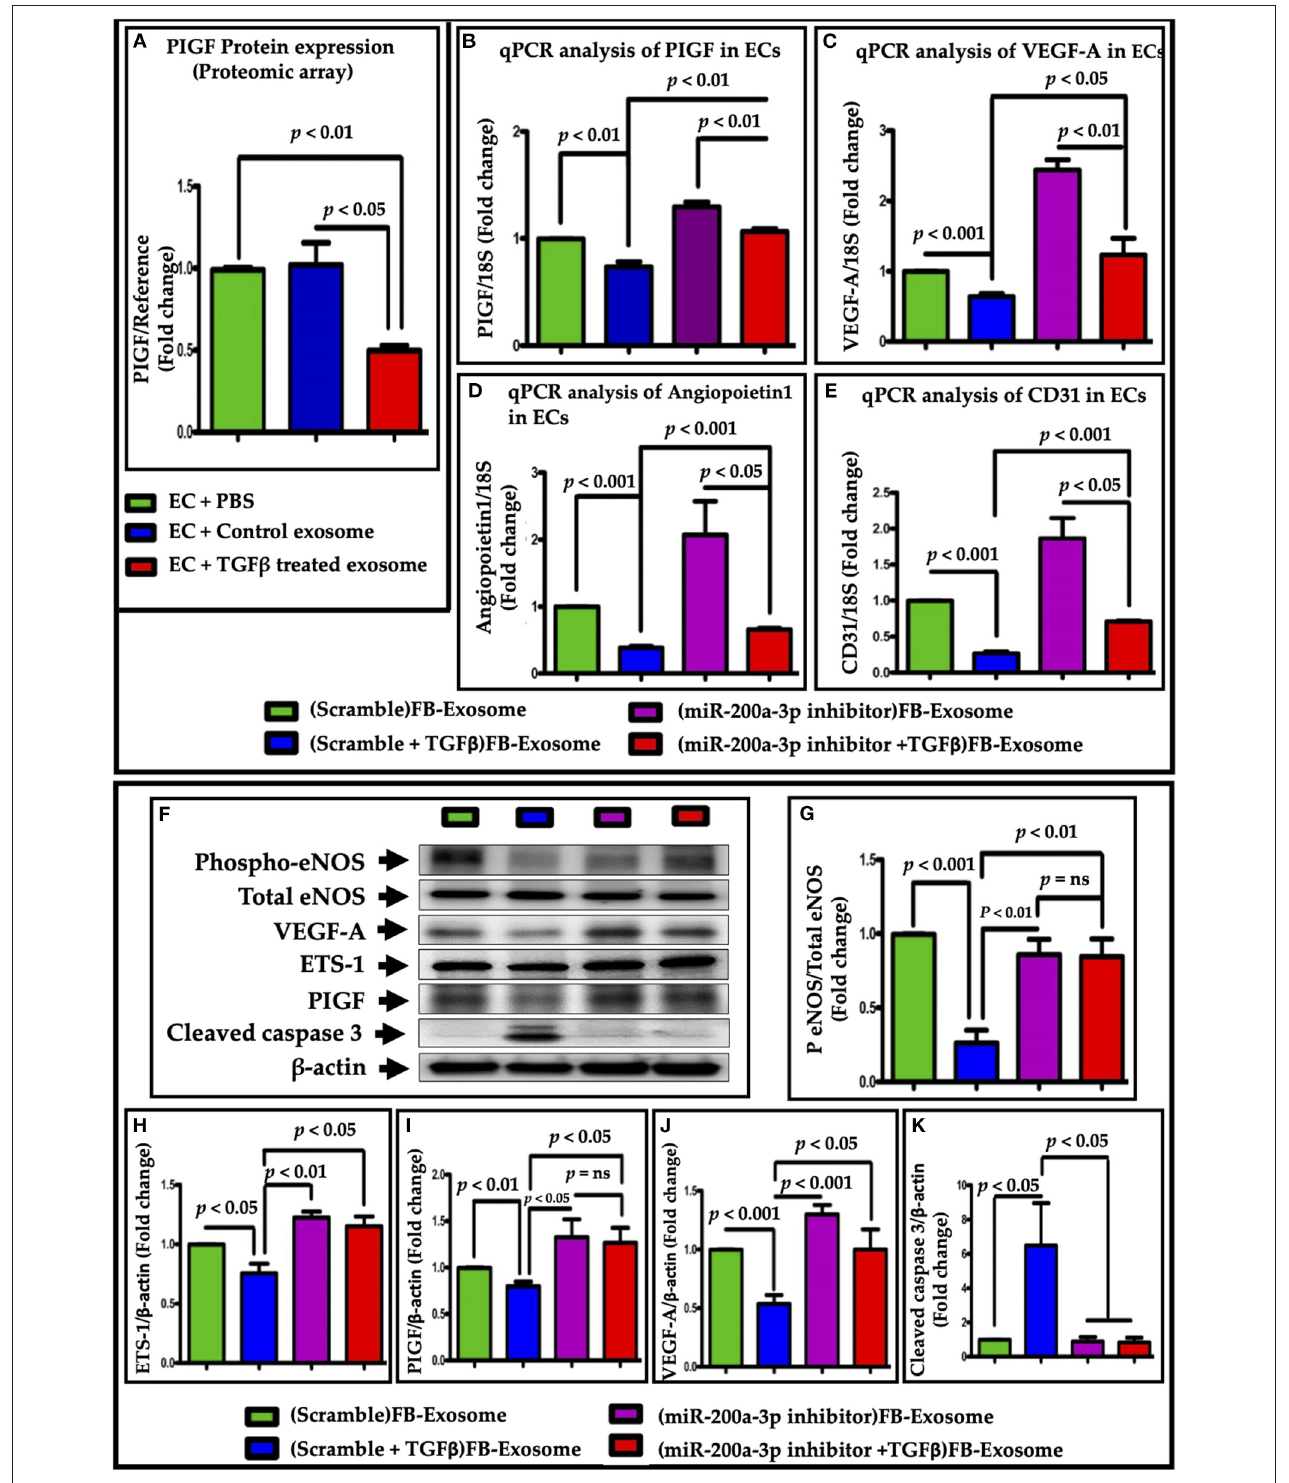
FIGURE 8 | miR-200a-3p packaged in fibroblast-derived exosomes altered expression of endothelial functional genes via PIGF growth factor inhibition. (A) ELISA-based angiogenesis proteomic profiling revealed a greatly reduced expression of PIGF. (B) PIGF expression was increased in ECs upon treatment with exosomes with inhibited miR-200a-3p. qPCR data showing an improved endothelial function, as assessed by (C) VEGF-A, (D) angiopoietin1 and (E) CD31 genes expression, upon treatment with miR-200a-3p inhibited exosomes. (F–K) Western blot analysis was performed in the cell lysate isolated from ECs treated with modified exosomes (inhibited miR-200a-3p). Cleaved caspase 3 expression (F,K) showed that endothelial cell death was also observed in FB- TGF β -Exo treated cells which was significantly recovered after miR-200a-3p inhibition. P < 0.05 vs. control exosome and PBS treatment. “ns”, not statistically significant.